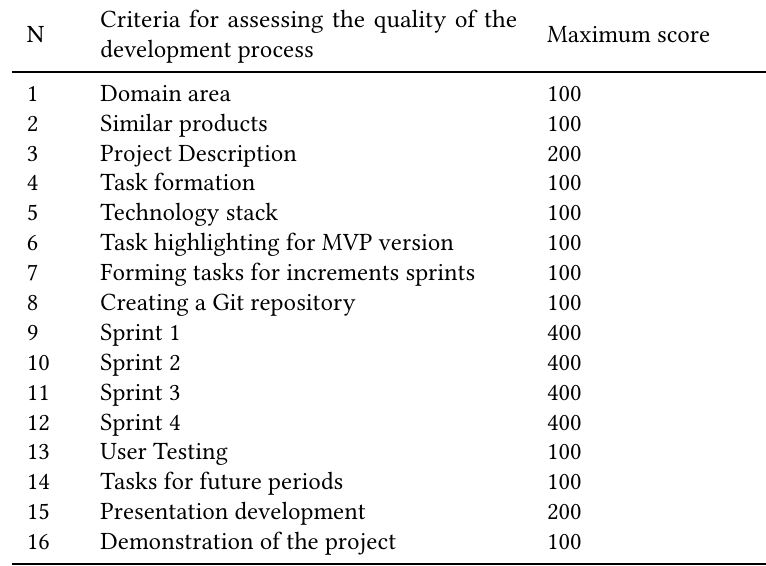
Criteria for assessing the quality of the development process (accounting system).